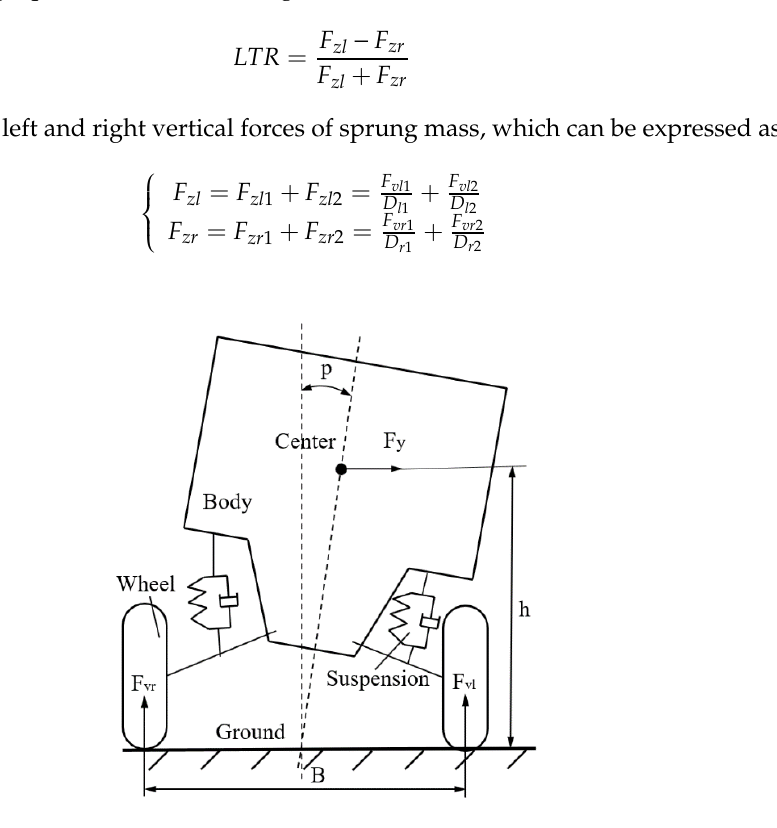
Table 2. Main results of comparison.